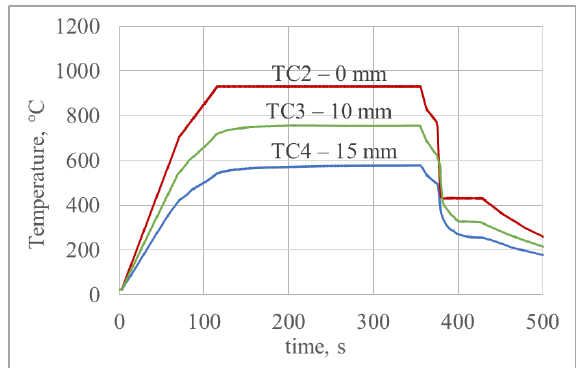
Figure 11. Thermal cycles recorded by the thermocouples during the Gleeble tests on USIBOR ® 2000 specimen in the condition of temperature of heated tools equal to 430 °C and quenching time 20 s.